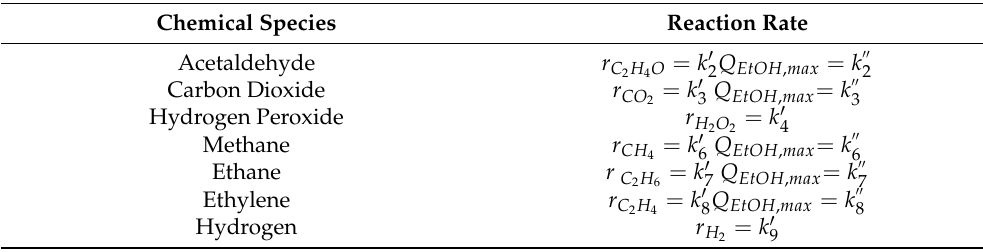
Table 2. Proposed Reaction Rates for the Chemical Species Formed in the Photocatalytic Water Splitting Reaction using Ethanol as an Organic